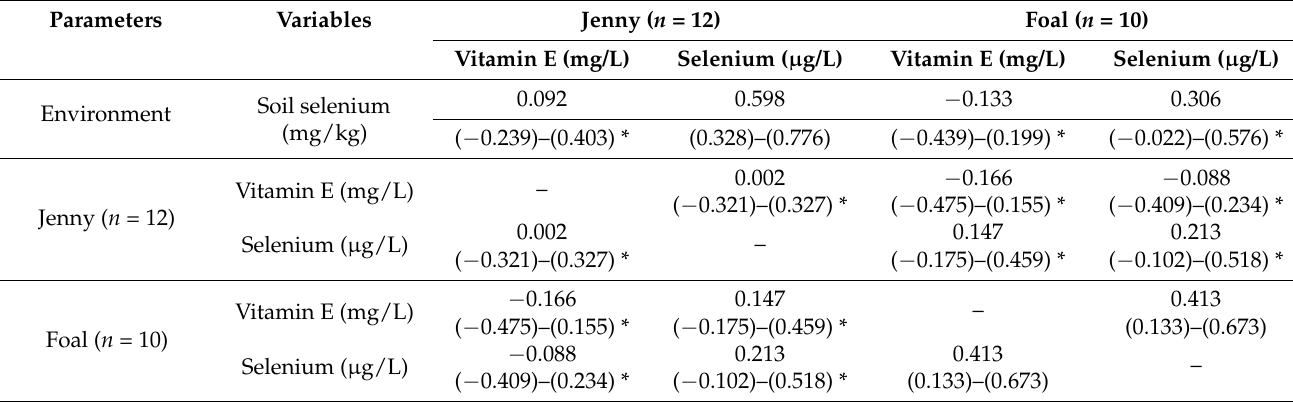
Table 1. Bayesian inference for Pearson’s linear correlations between environmental levels of selenium ( µ g/L) and levels of selenium ( µ g/L) and vitamin E (mg/L) in and between Miranda jennies and foals with independence of the place where sampling took